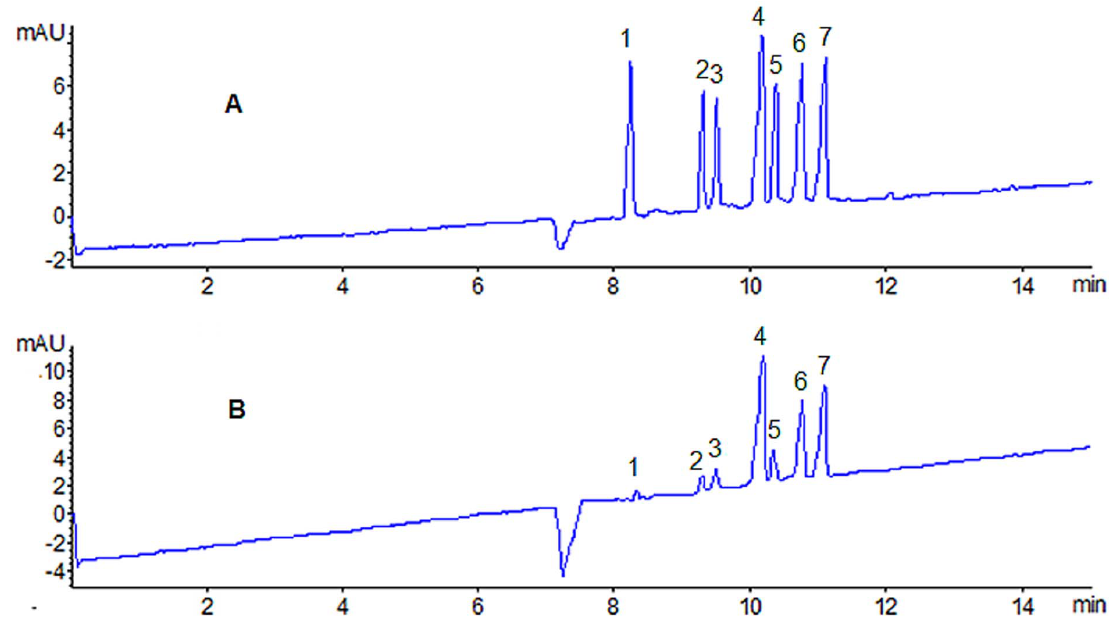
Figure 5. Capillary electropherograms of standard mixture of seven compounds (A) and Reduning injection (B) (n=3). Peaks: 1= caffeic acid, 2= isochlorogenic acid A, 3= isochlorogenic acid C, 4= chlorogenic acid, 5= isochlorogenic acid B, 6= neochlorogenic acid, 7= cryptochlorogenic acid. Experimental conditions: 50 m m i.d. 6 375 m m o.d. 6 60.5 cm length (52 cm effective length), uncoated; 20 mM NaH 2 PO 4 (pH 4.2) - 10 mM b -CD - 5% (v/v) acetonitrile, voltage, 25 kV; temperature, 22 u C; detection wavelength, 325 nm; pressure injection, 50 mbar for 5 s.